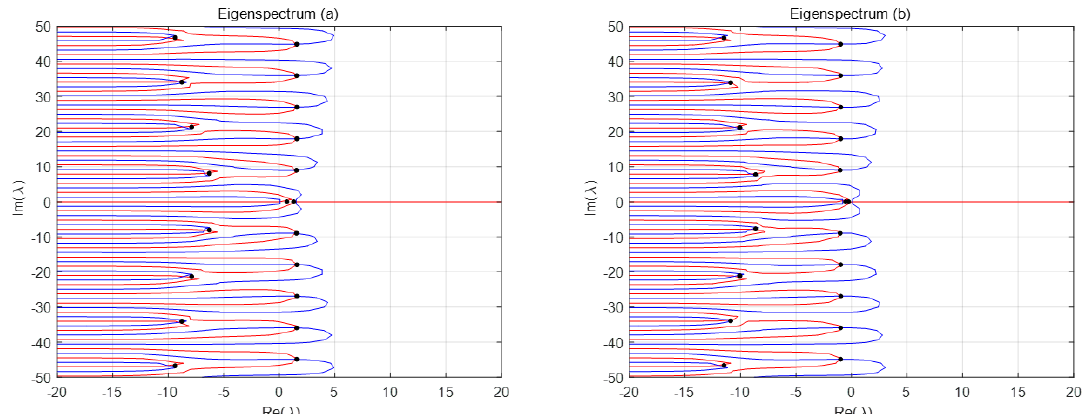
Figure 2. Rightmost spectrum of the characteristic equation. The spectrum values are denoted as black dots. The blue and red lines are the isolines of the real and imaginary parts of the characteristic equation to zero, respectively. ( a ) Without state feedback. A few eigenvalues are located in the right-half plane of the imaginary axis. ( b ) With a state feedback controller. All eigenvalues are located in the open left-half plane of the imaginary axis.